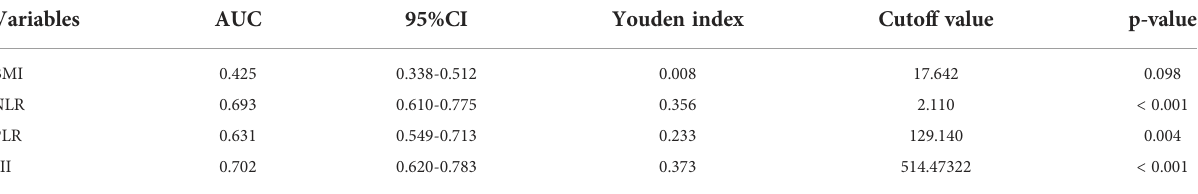
TABLE 2 ROC analysis of in fl ammation index and BMI for response to intravesical BCG